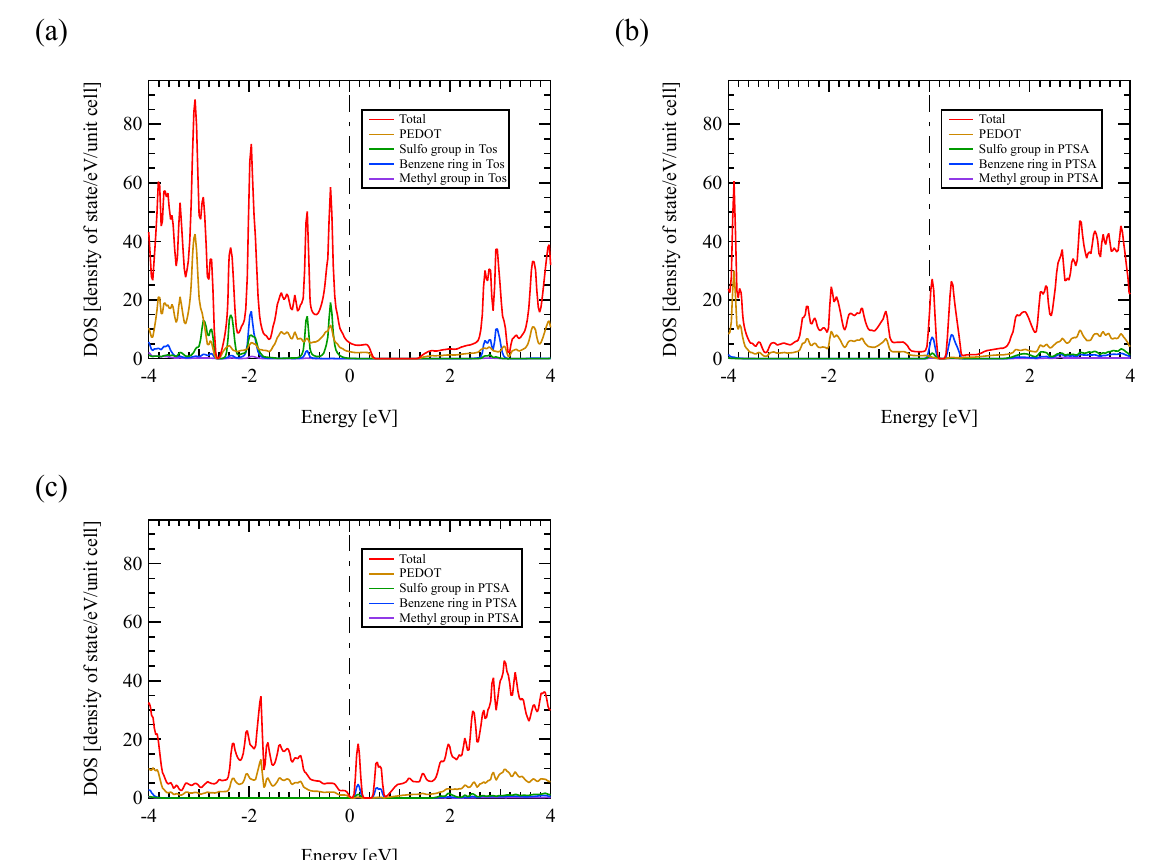
Figure 3. TDOS and PDOS projected for PEDOT and sulfo group, benzene ring, and methyl groups in the dopant of ( a ) PEDOT:Tos, ( b ) highly doped PEDOT:PTSA, and ( c ) poorly doped PEDOT:PTSA. The Fermi energy is at 0 eV.